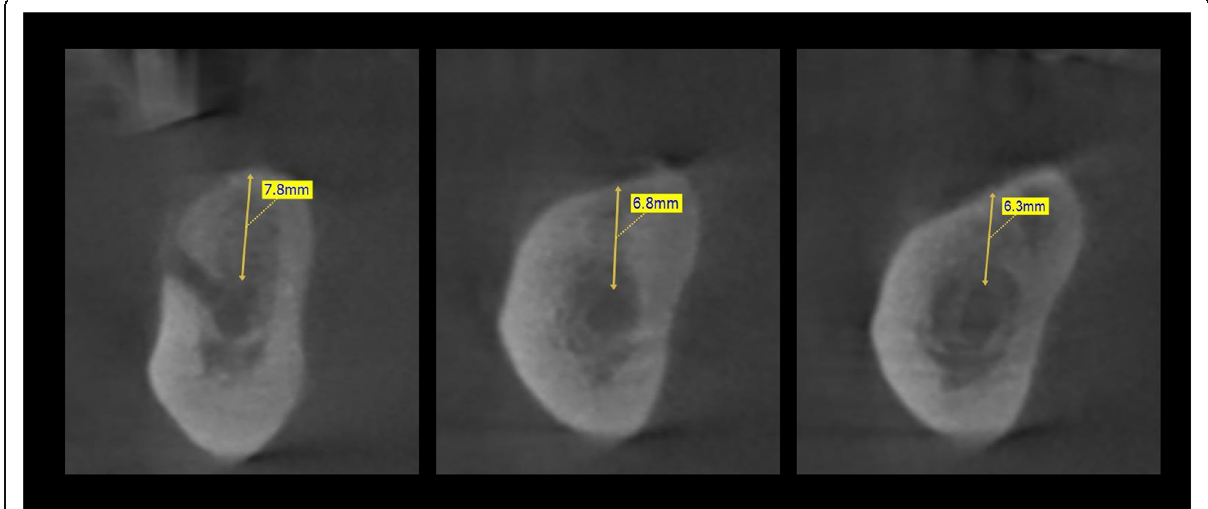
Fig. 2 A CT scan before